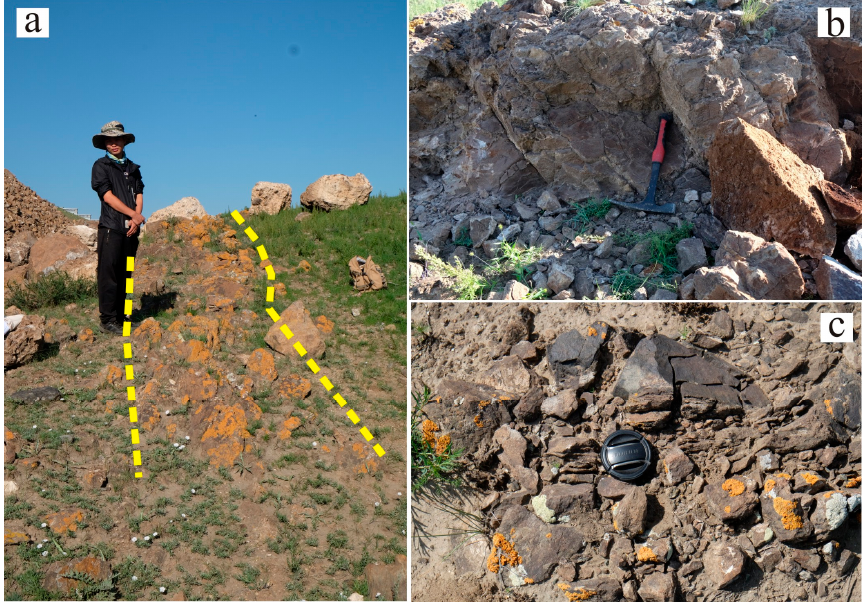
Figure 2. ( a ) A segment of a typical Dol-dyke around the Bayan Obo deposit. ( b ) Outcrop of the Dol- dyke. ( c ). Fenitization of the country rocks near the Dol-dyke.